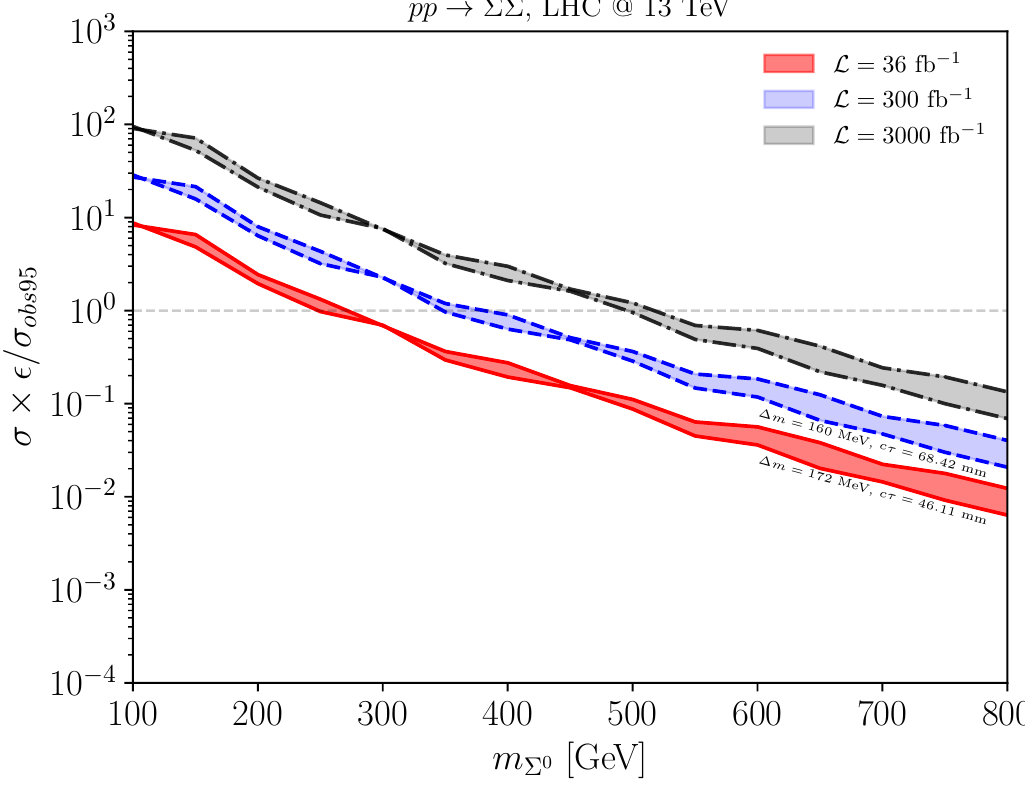
Figure 5 . 95% CL exclusion limits at √ s = 13 TeV LHC versus m Σ 0 . The red, the blue, and the gray bands correspond to = 36 , 300 , and 3000 fb − 1 respectively. σ obs95 is the model-independent L pair production cross section reported in ref. [35] for the chargino and σ is the pair production cross section of the real triplet. The “band” feature for the latter results from the lifetime variation of Σ ± at two loop. The lower boundary of each band corresponds to ( ∆ m = 172 MeV, cτ = 46 . 11 mm), while the upper boundary corresponds to ( ∆ m = 160 MeV, cτ = 68 . 42